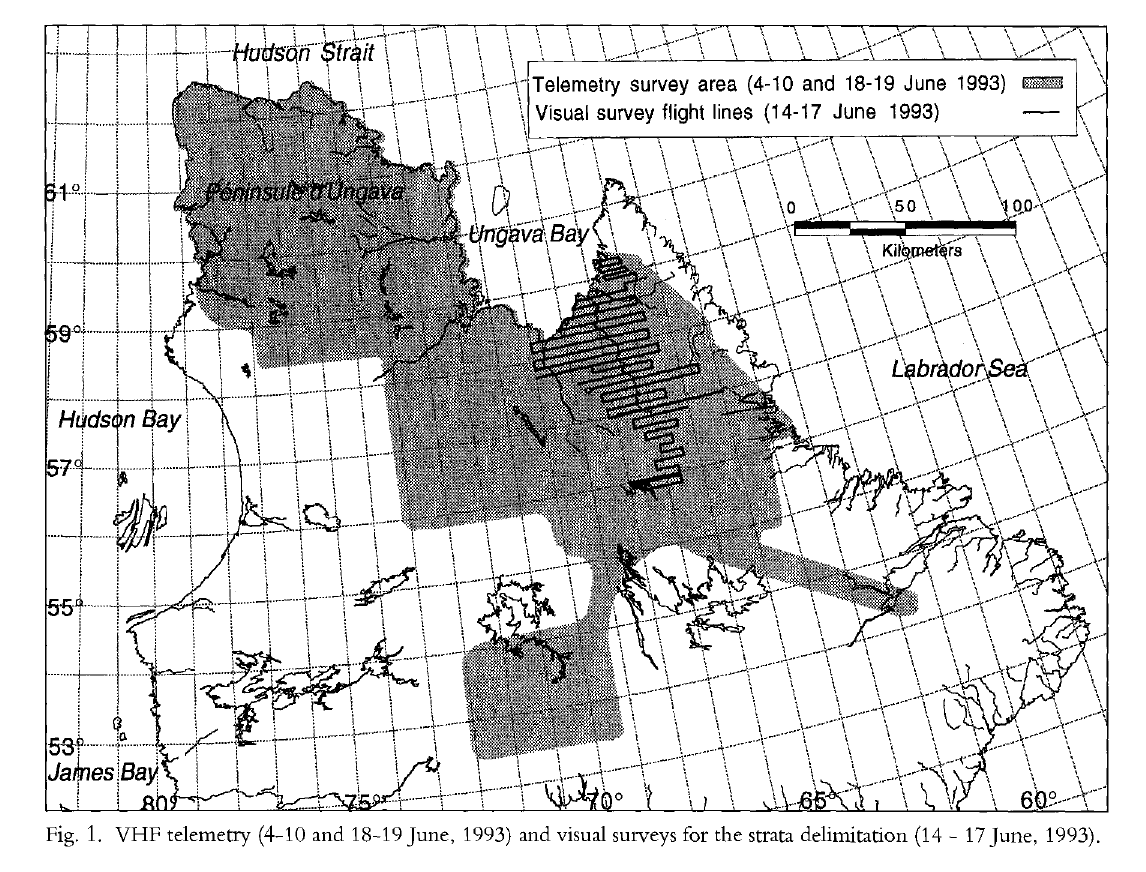
Fig. 1. VHF telemetry (4-10 and 18-19 June, 1993) and visual surveys for the strata delimitation (14 - 17 June,